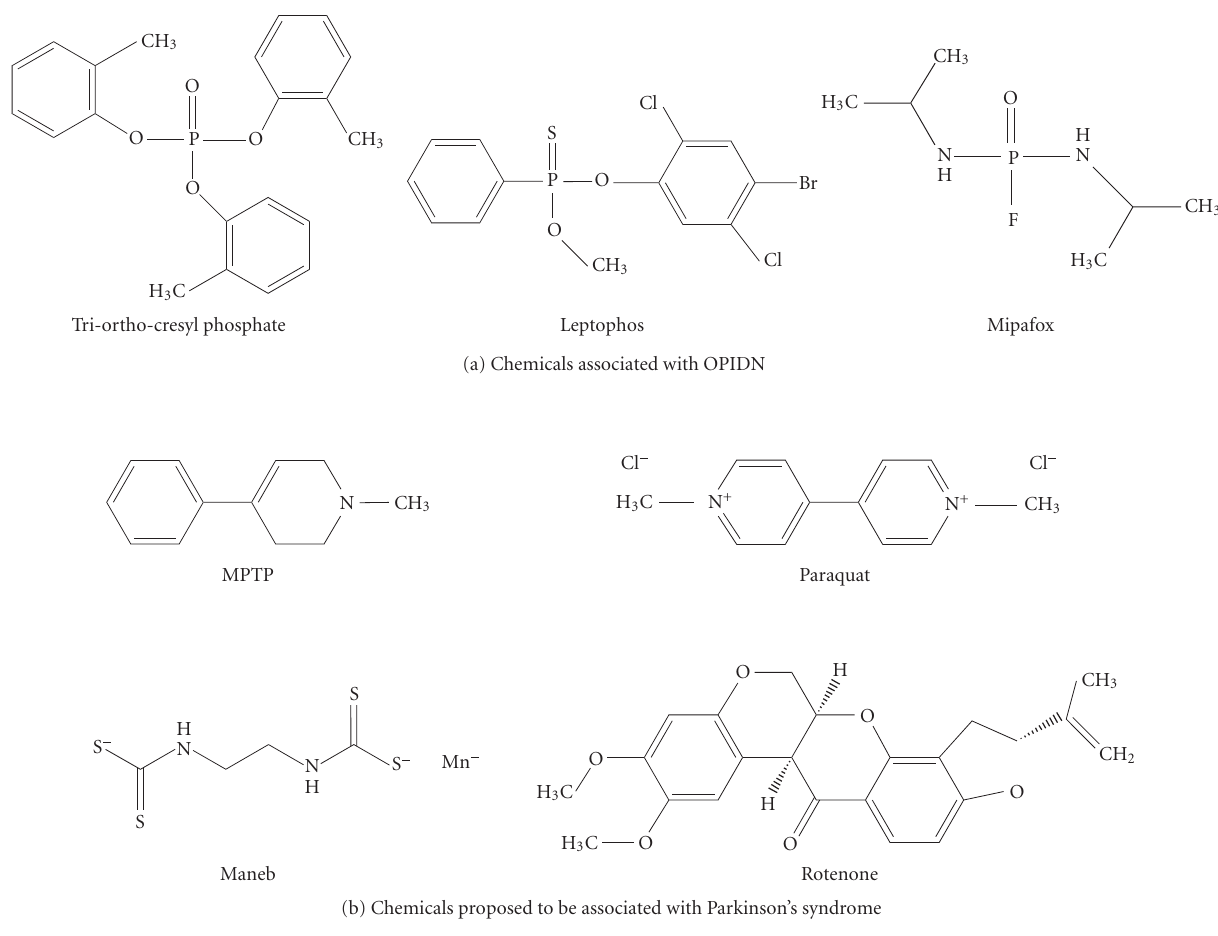
Figure 1: Chemical